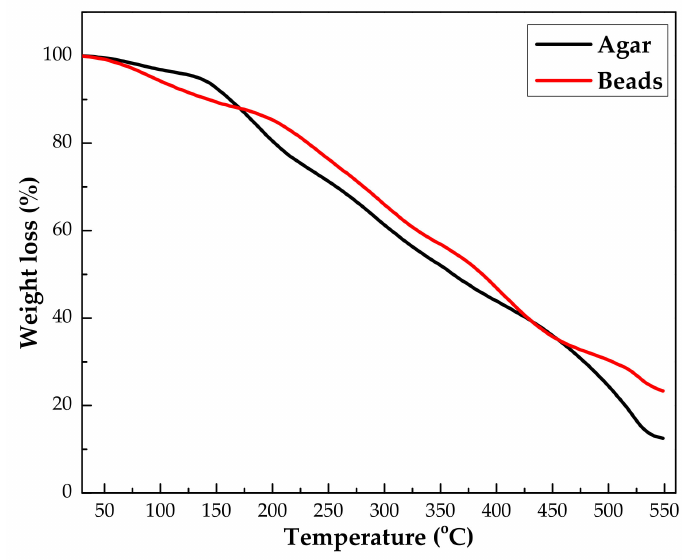
Figure 5. TGA curve for agar and agar–alginate-IL